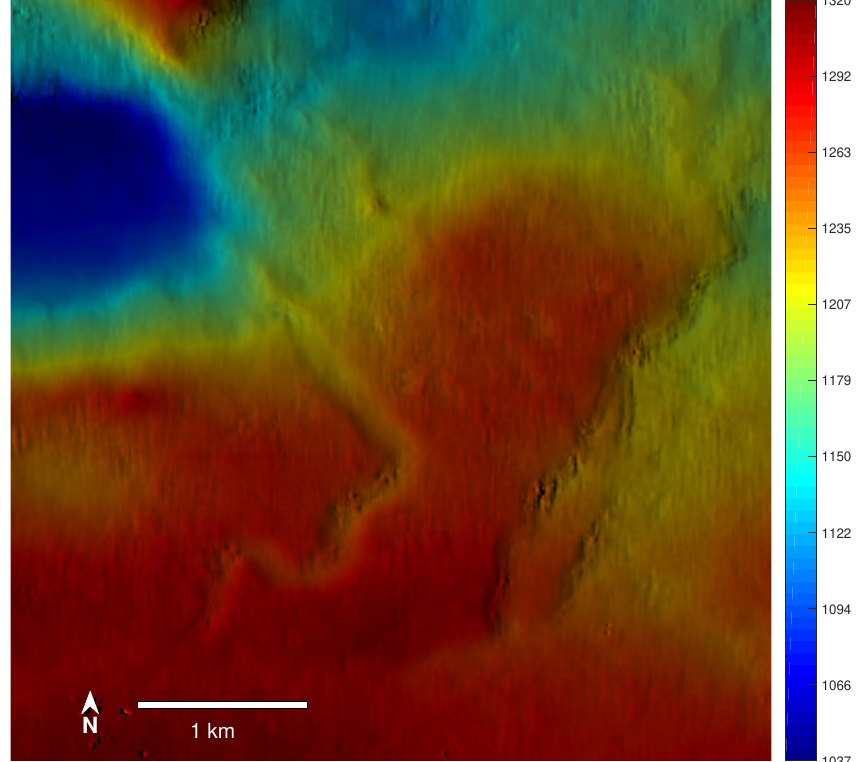
Figure 3. Color-coded stereo DTM created with the Ames Stereo Pipeline. Note that the DTM is already sub sampled by a factor of two by default.